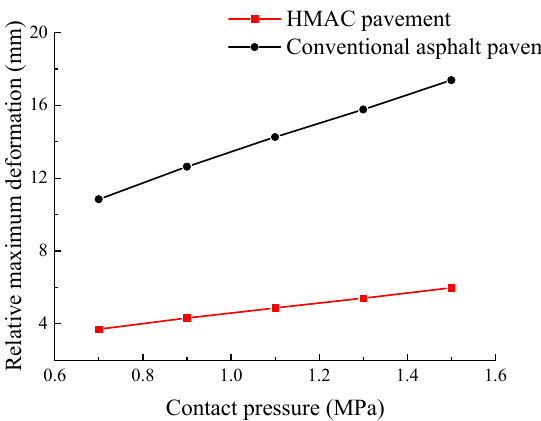
Figure 15. Comparison of maximum relative deformation at different tire contact pressure.